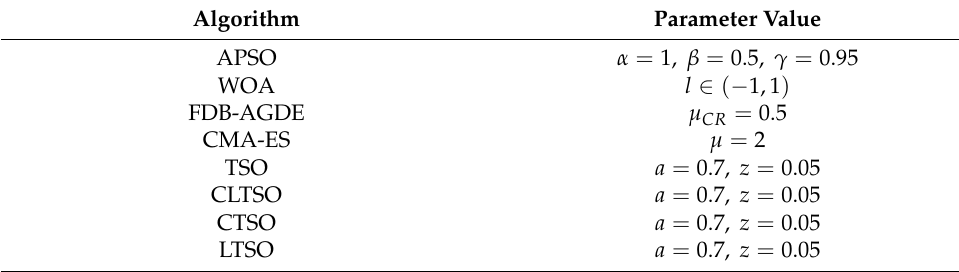
Table 3. Parameter values of the